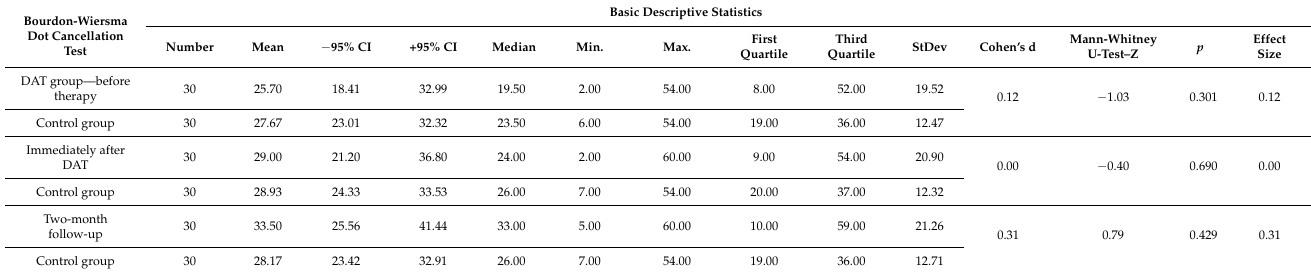
Table 9. Bourdon–Wiersma Dot Cancellation Test—comparison of DAT group scores achieved over time to the results of the